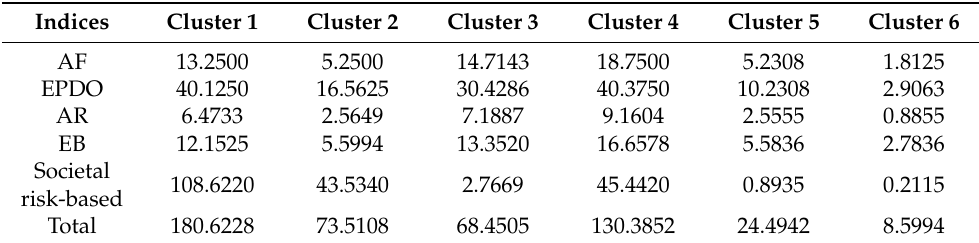
Figure 5. Number of crash-prone sections located in each cluster (neuron). Table 1. The centers of each cluster based on five indicators.